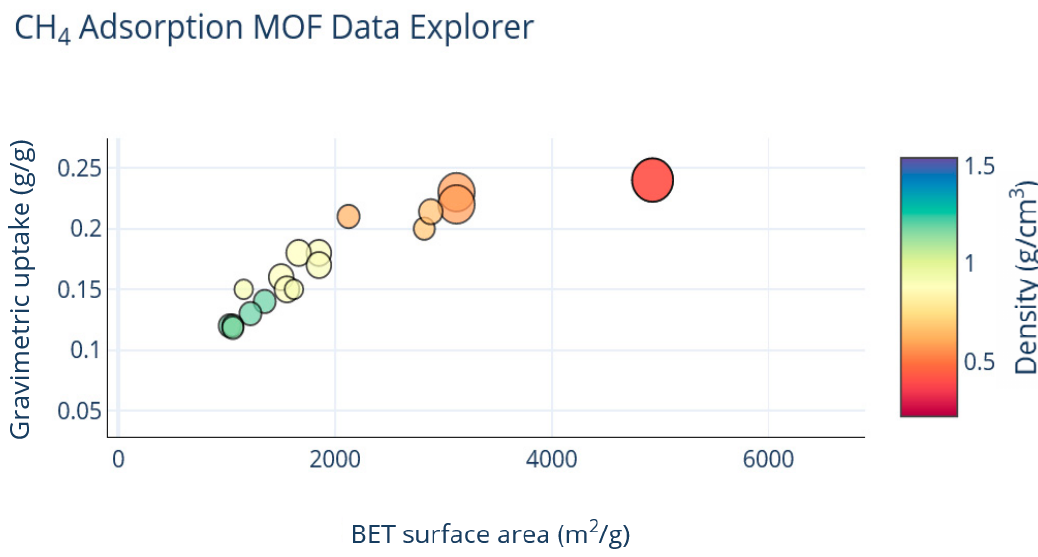
Figure 5. QSPR for CH 4 storage in MOFs. CH 4 gravimetric uptake at 298 K and 35 bar against BET surface area. Each point represents a MOF. The data points are color-coded for MOF density, and the diameter of each circle represents the largest cavity diameter (LCD) of each MOF.